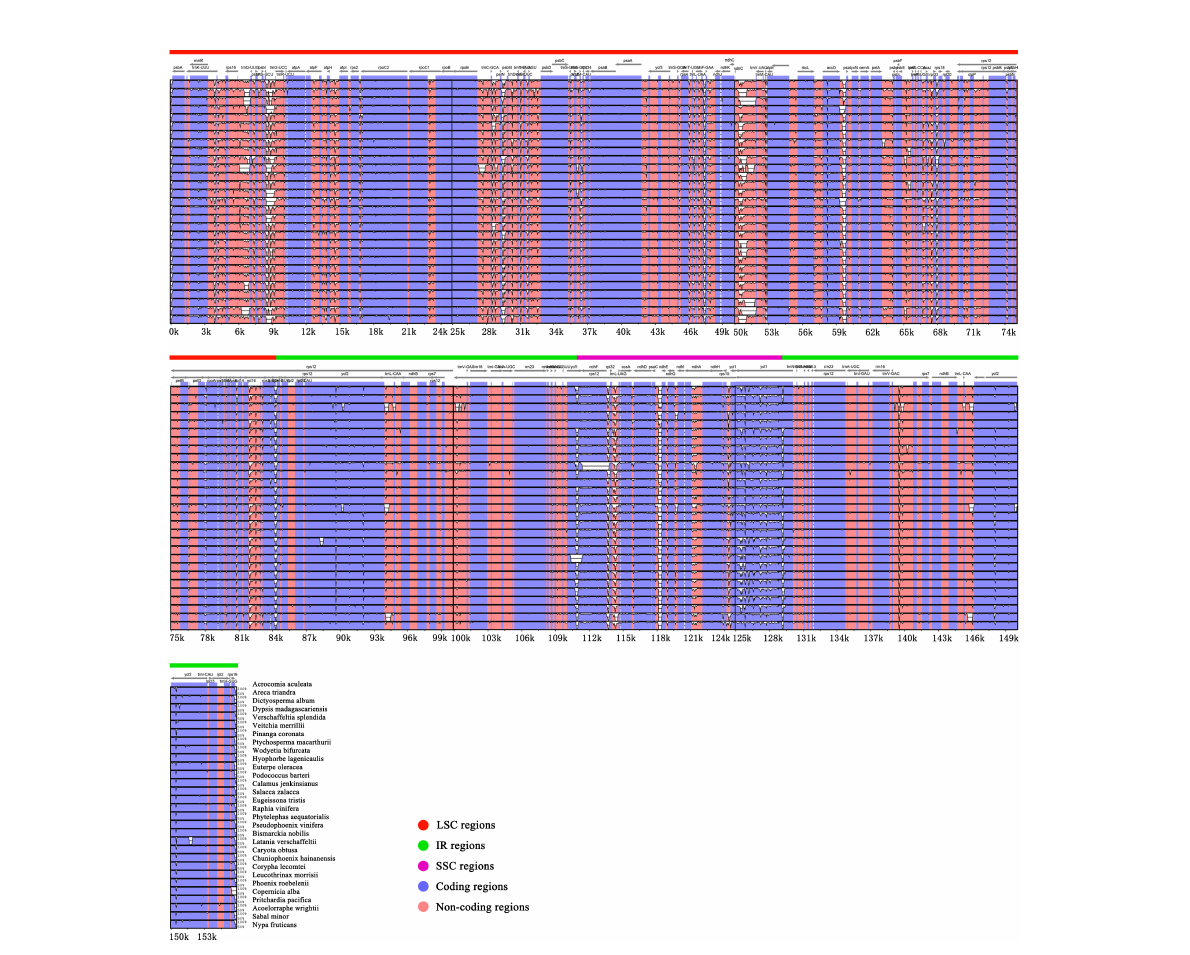
FIGURE 3 Comparative visualization of chloroplast genome sequence differences in Arecaceae. The protein coding and non-coding regions correspond to blue and red. The x-axis uses Acrocomia aculeata as reference sequence and y-axis indicates the percentage of sequence identity